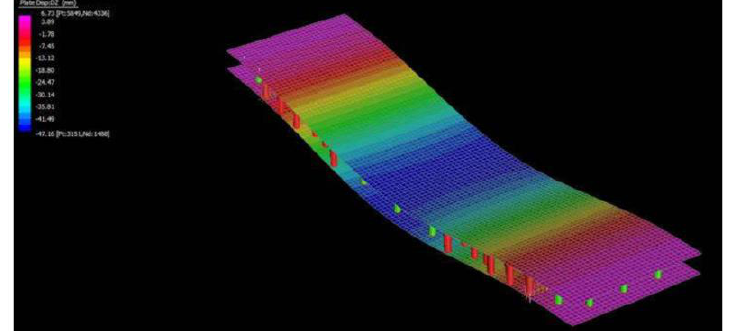
Fig. 9 Numerical modelling of prototype panel tests by